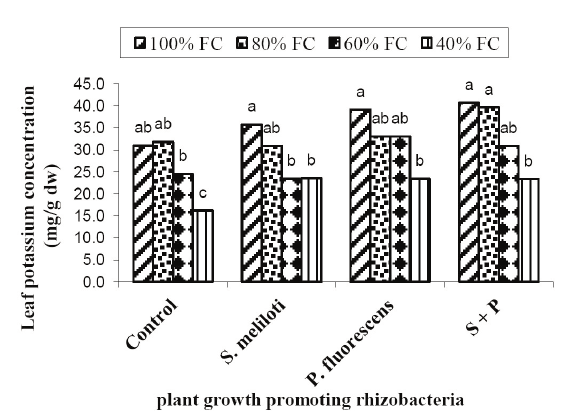
fig. 7 - Interaction of PGPR and soil water content on k concen- tration of fenugreek